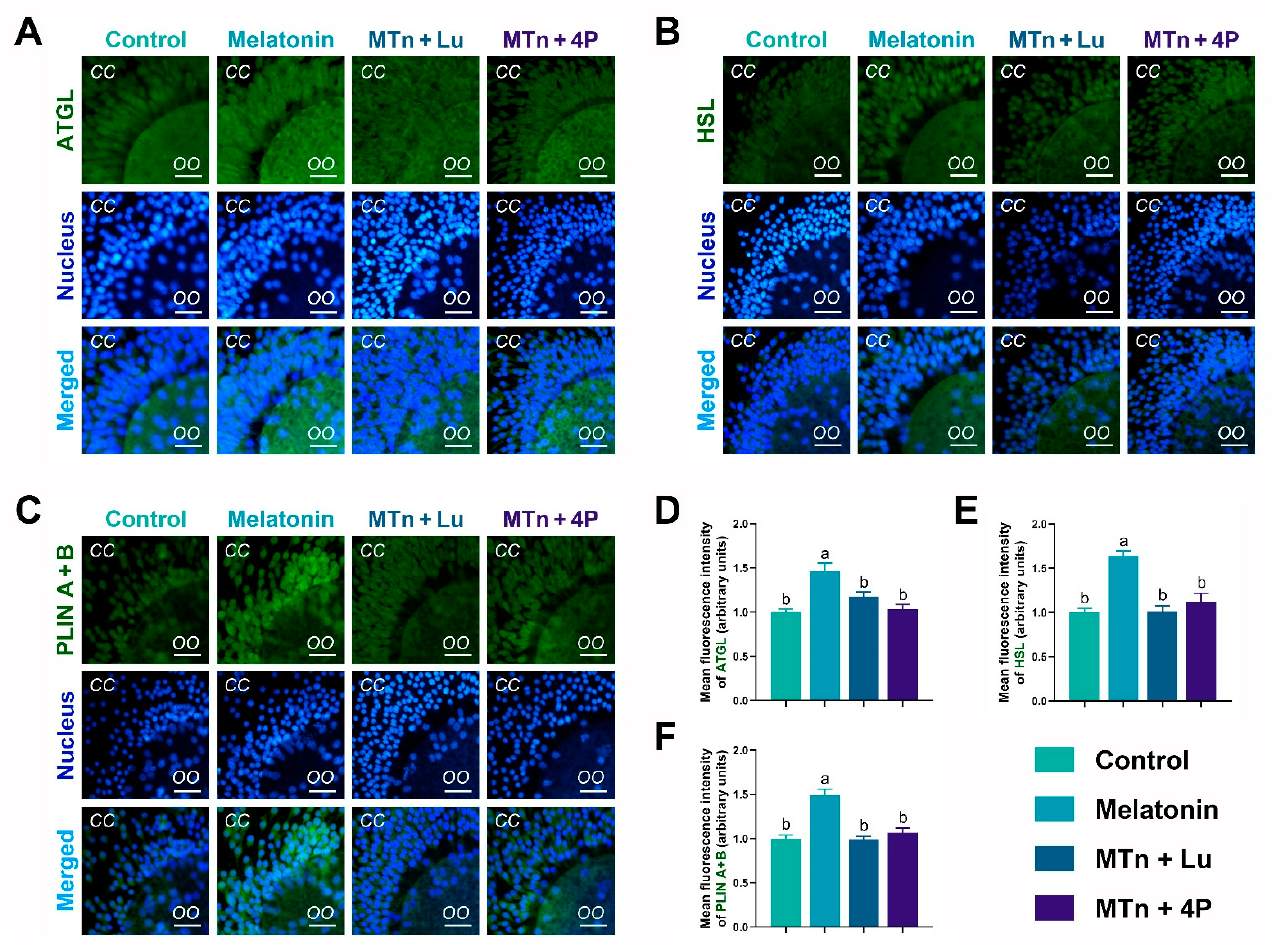
Figure 3. Immunofluorescence analysis of lipolysis proteins in cumulus cells. ( A , D ) ATGL, ( B , E ) HSL and ( C , F ) PLIN A + B. Melatonin/MTn, 10 − 9 mol/L melatonin; Luzindole/Lu, 10 − 9 mol/L Luzindole; 4P-PDOT/4P, 10 − 9 mol/L 4P-PDOT. Scale bar = 30 µm. Different letters denote significant difference ( p < 0.05).